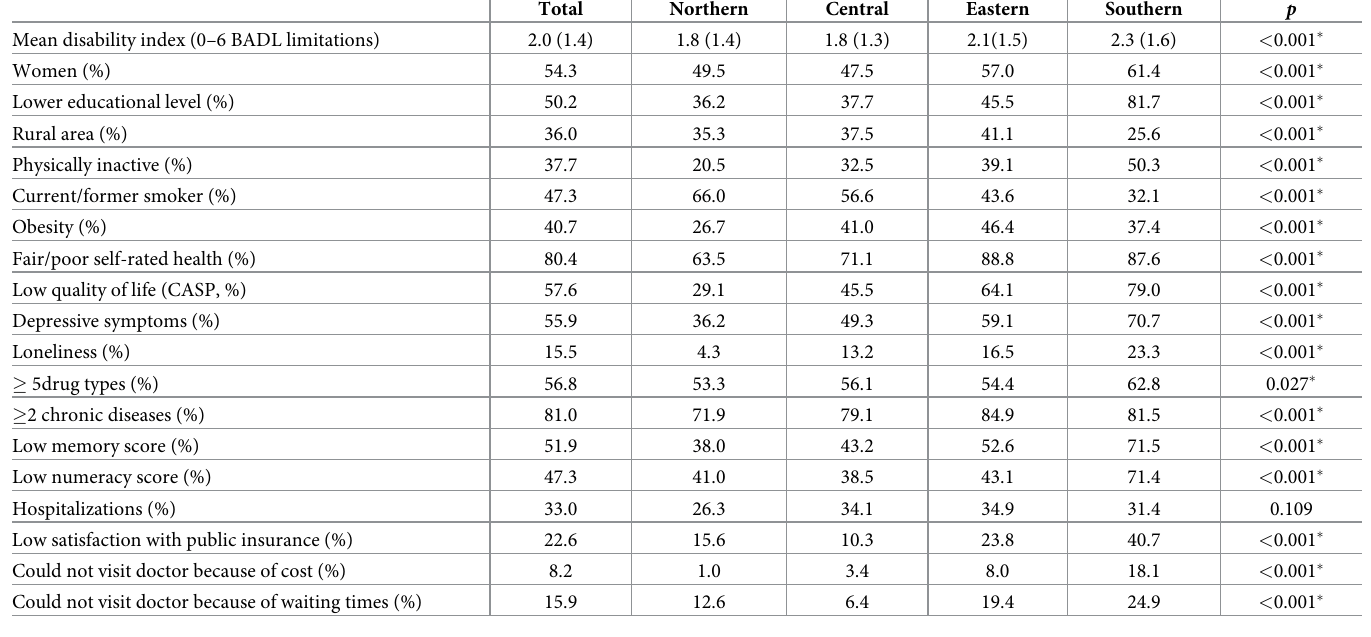
Table 2. Descriptive (frequencies or mean, and standard deviation) and bivariate (Chi-square and ANOVA tests) analysis of disabled older adults in Europe aged 65–74 (n = 2,023), according to European regions and independent variables in 2015. Total Northern Central